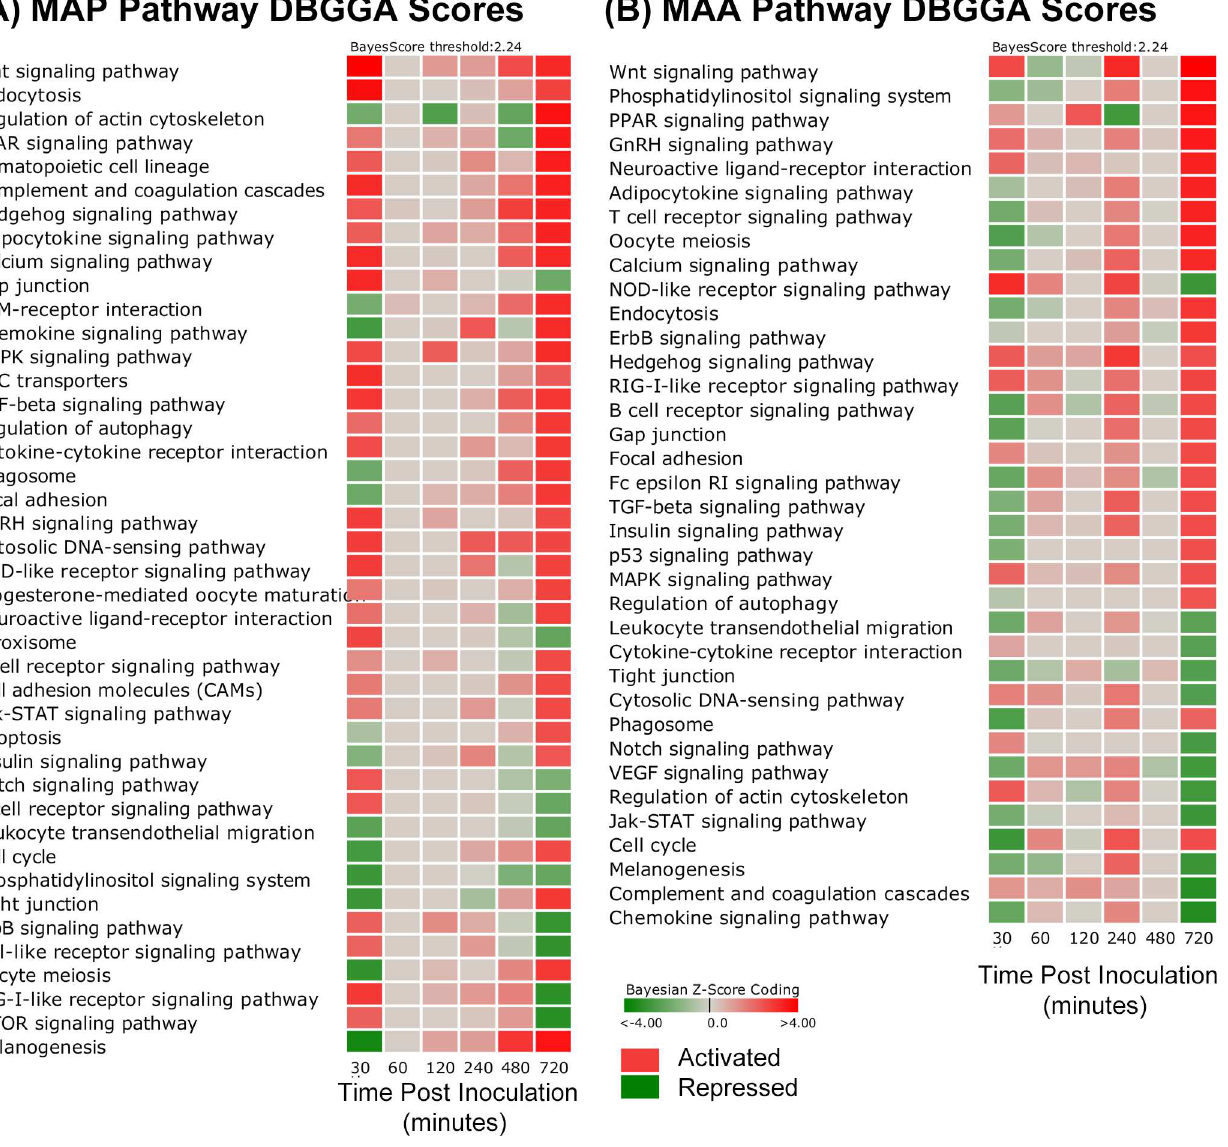
Fig 2. Heatmapcomparisonof significantlyperturbedpathways (DBGGA|zscore| (cid:21) 2.24)for the (A) MAP vs PBS and (B) MAA vs PBS. Red indicates activation and green indicatesrepression.The gradient in color indicatesmagnitudeof perturbation(i.e., higher|zscore|).